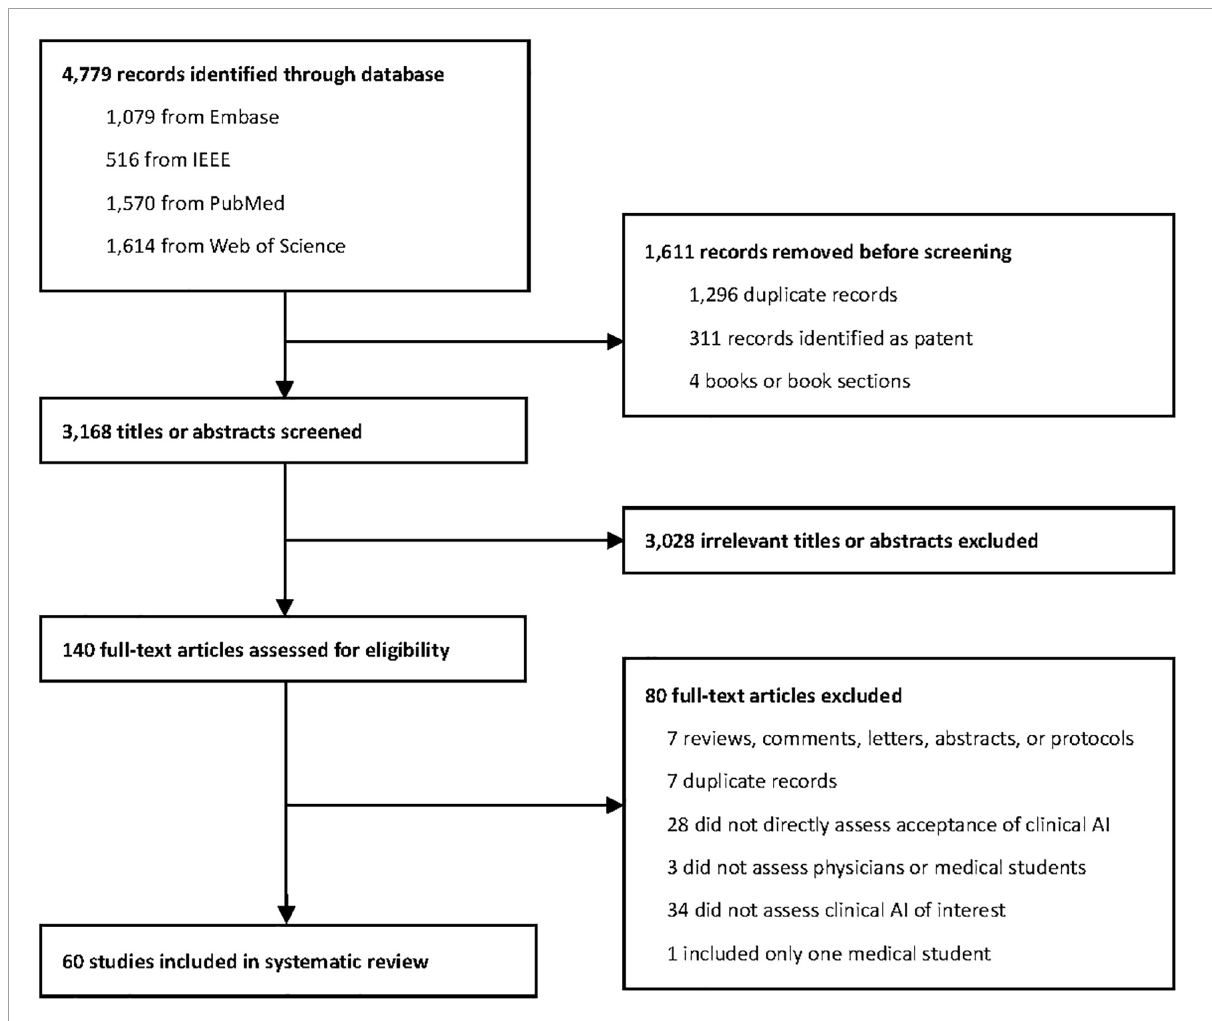
FIGURE1 PRISMA (Preferred reporting items for systematic reviews and meta-analysis) systematic review flow diagram. Displayed is the PRISMA flow of each article selection